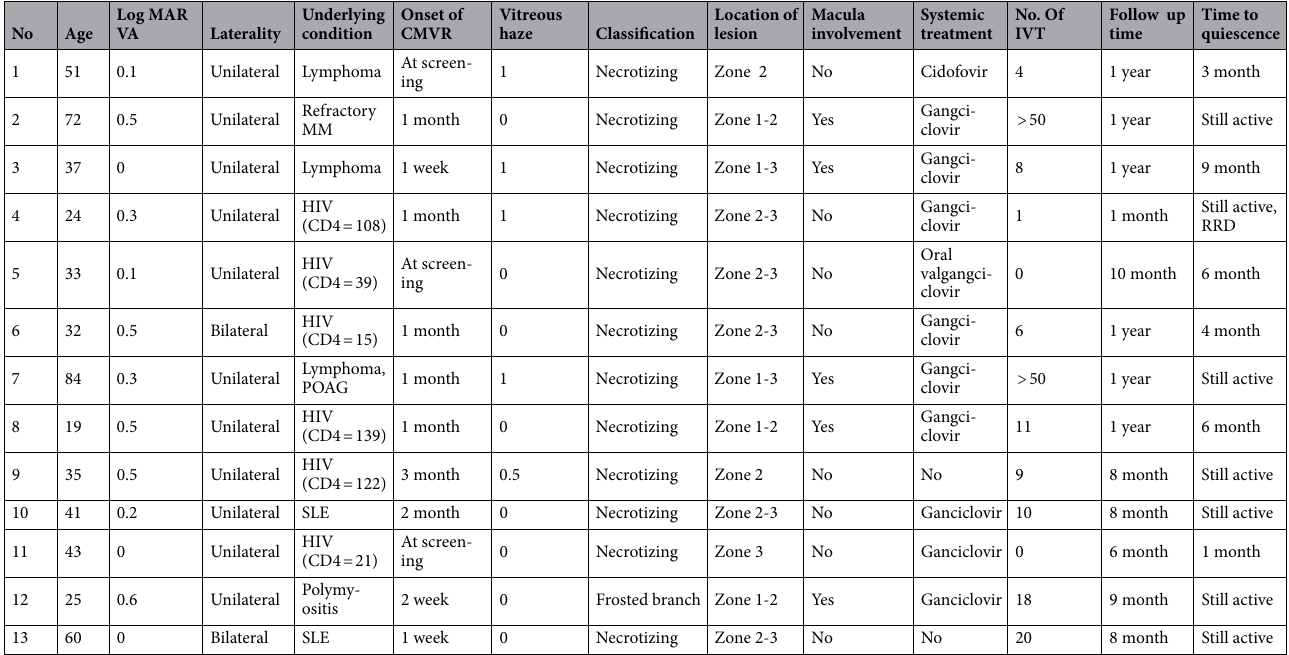
Table 1. Demographic characteristics of study participants. CMVR cytomegalovirus retinitis, HIV human immunodeficiency virus, IVT intravitreal ganciclovir injection, MM multiple myeloma, POAG primary